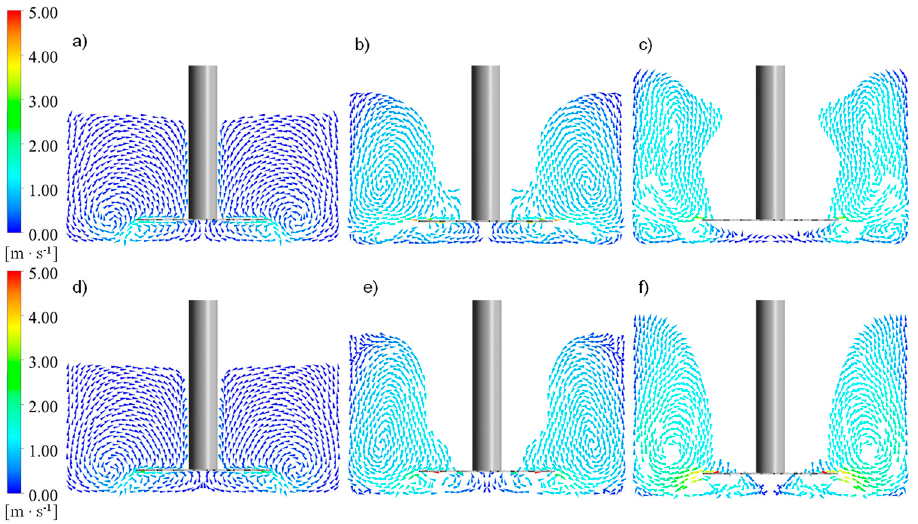
Figure 4. Velocity vectors for case 2: ( a ) 500, ( b ) 1200, and ( c ) 3000 rpm; and case 3: ( d ) 500, ( e ) 1200, and ( f ) 3000 rpm.